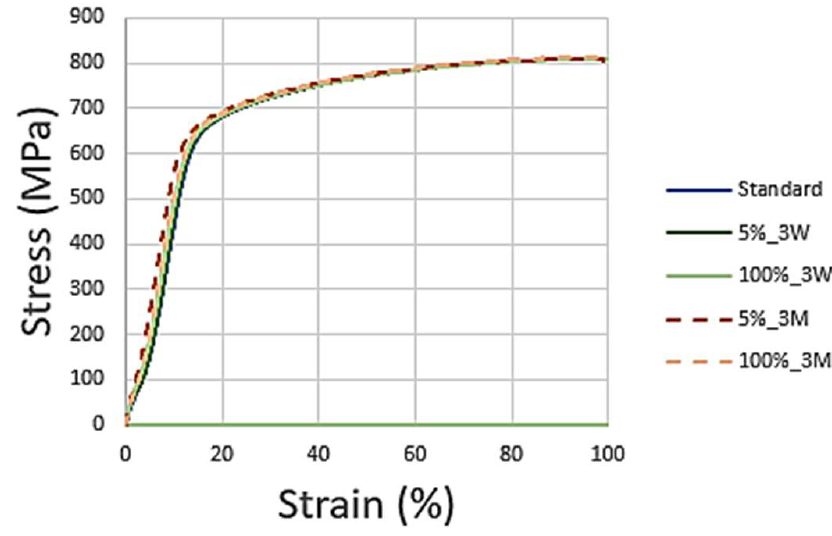
Figure 17. Duplex 14462 stress–strain curves after three weeks and three months.